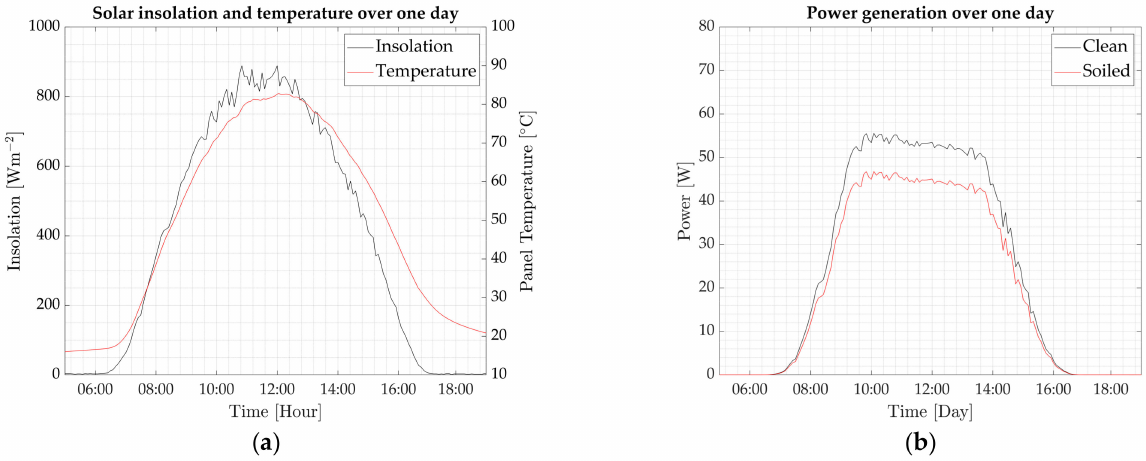
Figure 5. ( a ) Solar irradiance value and panel temperature of the clean PV panel over a one-day period; ( b ) power output from the PV panel over a one-day